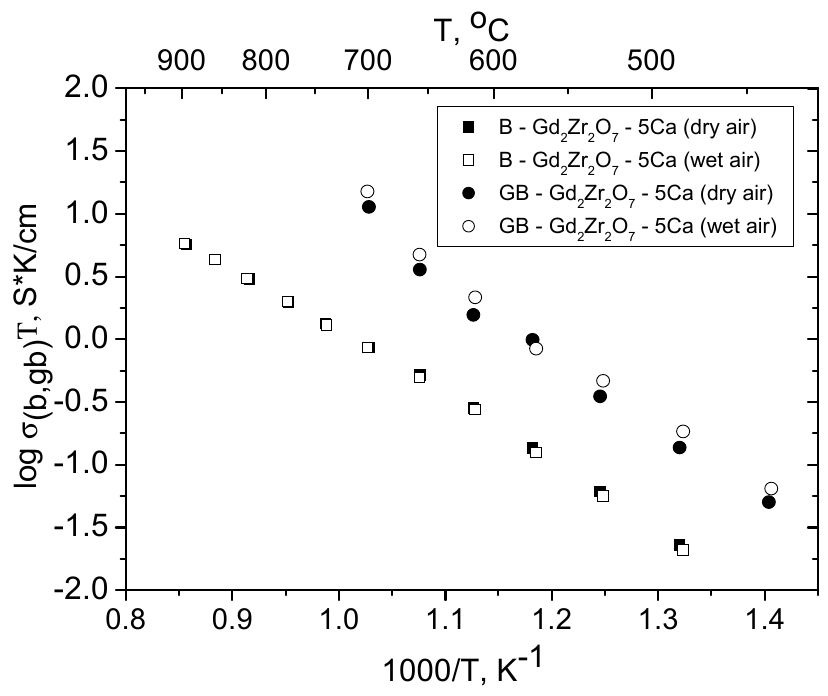
Figure 10. Bulk and grain-boundary conductivities of Gd 2 − x Ca x Zr 2 O 7 − x / 2 (x = 0.1) in dry and wet air. As in the case of the Sm 2 − x Ca x Zr 2 O 7 − x / 2 (x = 0.1) solid solution, we assume that a high-conductivity of Gd-doped phase is due to cubic perovskite CaZrO 3 , which could be present on grain